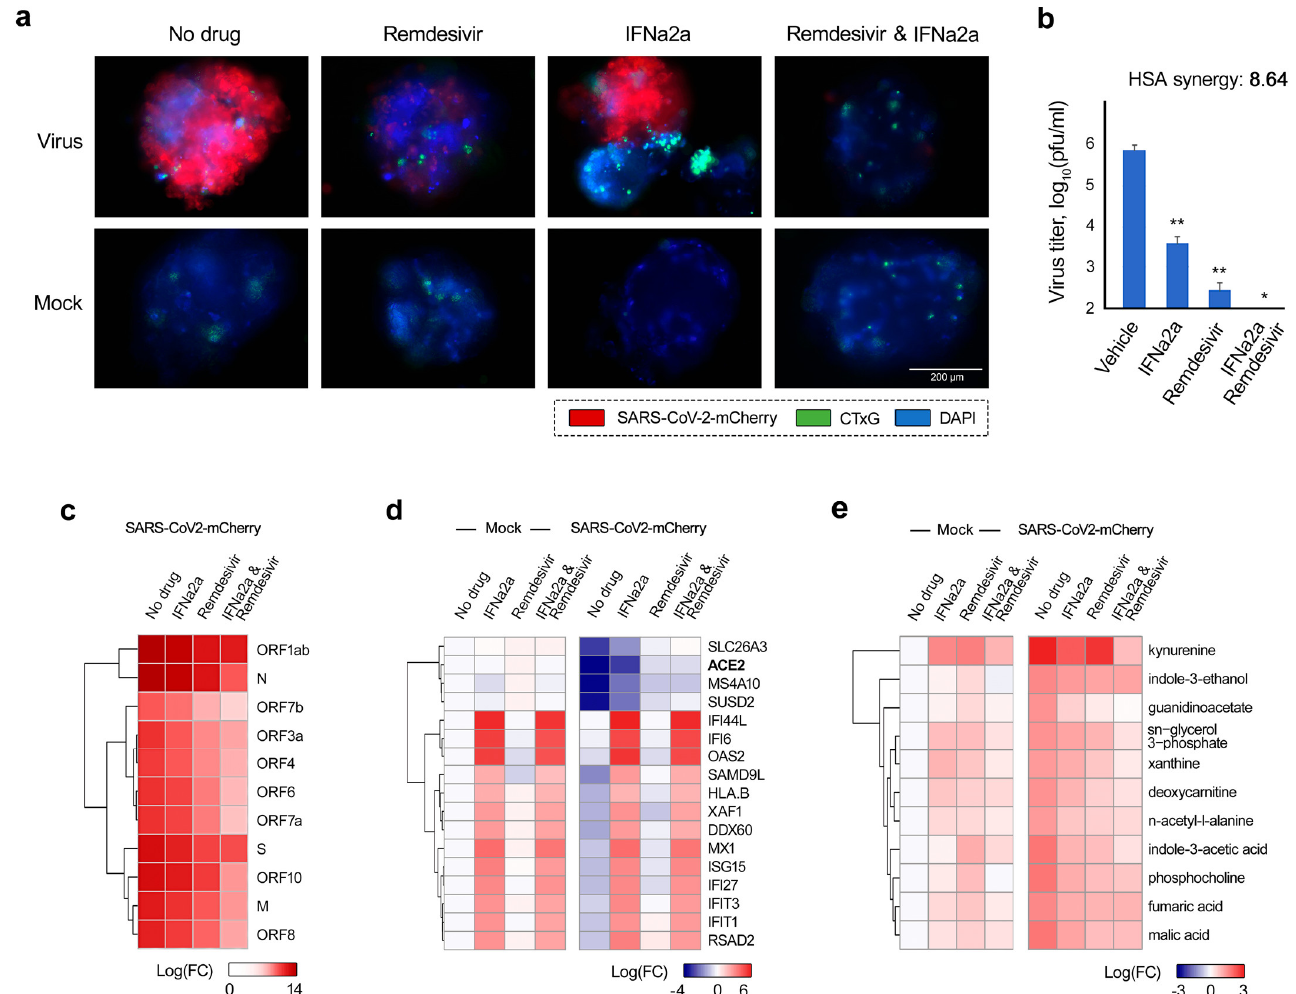
Figure 6. Antiviral effect of IFNα2a–remdesivir combination in human lung organoids (LOs). ( a ) LOs were treated with 0.5 μM remdesivir, 5 ng/mL IFNα2a, their combination, or vehicle, and infected with SARS-CoV-2-mCherry (moi = 0.1) or mock. Fluorescence of drug- or carrier-treated SARS-CoV-2-mCherry-infected LOs was detected at 72 hpi. Virus infection, cell nuclei, and cytotoxicity are shown in red, blue, and green, respectively. Scale bars, 200 μm. ( b ) The effects of IFNα– remdesivir combination on viral replication in LOs, measured by plaque reduction assay. Mean ± SD; n = 3. Statistical significance is indicated with asterisks (* p < 0.05, ** p < 0.1, Wilcoxon test), the significance levels were compared to the vehicle. Synergy score for single dose of IFNα–remdesivir combination was calculated as an excess combinatorial effect